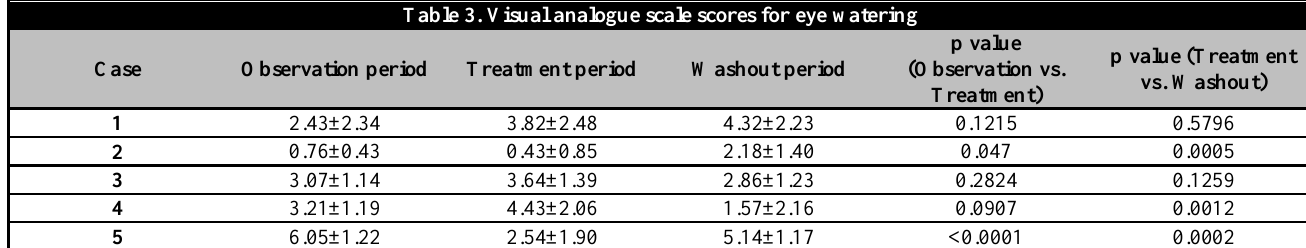
Table 3. Visual analogue scale scores for eye watering